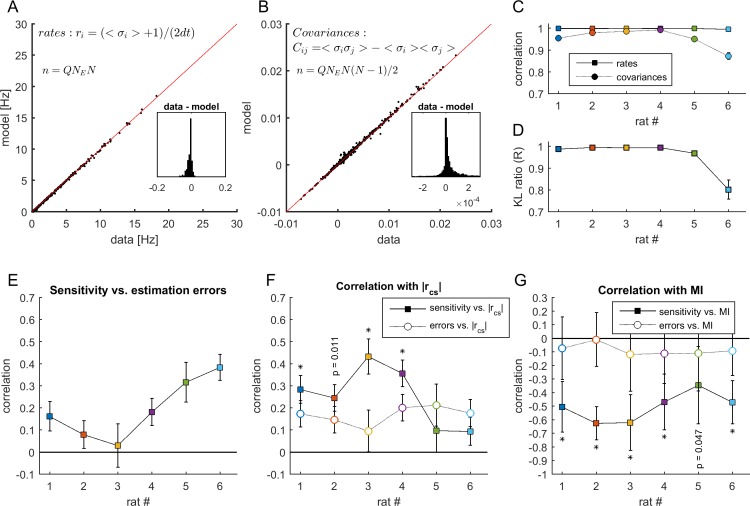
Estimation errors and sensitivity.(A-B) Comparison between the firing rates and covariances measured in the data and those estimated by the MEM. Data from rat 4. Each point represents the activity of a neuron (in panel A) or co-activity of a pair of neurons (in panel B) from a given neuronal ensemble and at a given epoch. The data of all neuronal ensembles and all epochs are presented. Insets show the resulting differences between statistics estimated from the data and from the model. (C) Correlation between the firing rates and covariances measured in the data and those estimated by the MEM, for each dataset. (D) Average Kullback-Leibler ratios for all learned models of each dataset. Error bars indicate SEM. (E) Correlation between sensitivity s and estimation errors Err. (F) Full squares: correlation between sensitivity and rcs (same values as in Figure 5F). Open circles: correlation between estimation errors and rcs. For each dataset the correlation coefficients were compared, given the observed correlations in panel E using Meng's z-test for dependent correlations, *: p < 0.01. (G) Full squares: correlation between sensitivity of firing rates and MI (same values as in Figure 6D). Open circles: correlation between firing rate estimation errors and MI. *: p < 0.01, Meng's z-test for dependent correlations. In panels (C) and (E–G), error bars indicate correlation 95% confidence interval.